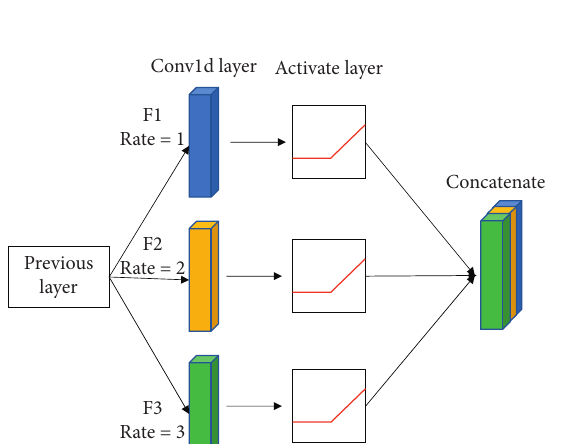
Figure 2: The proposed MS-CNN.